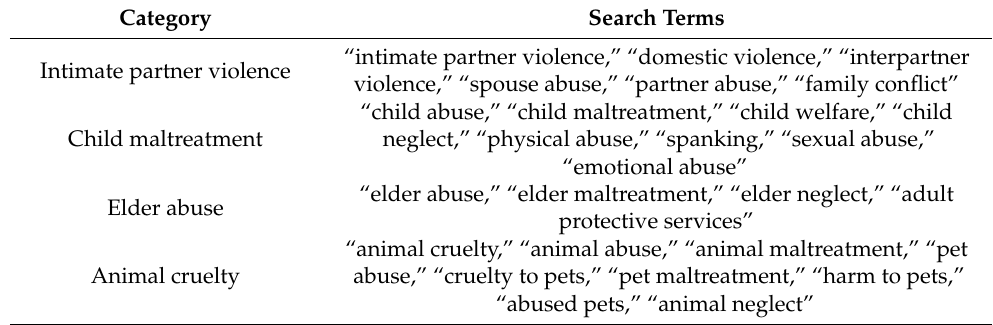
Table 1. Search terms used in combination to locate